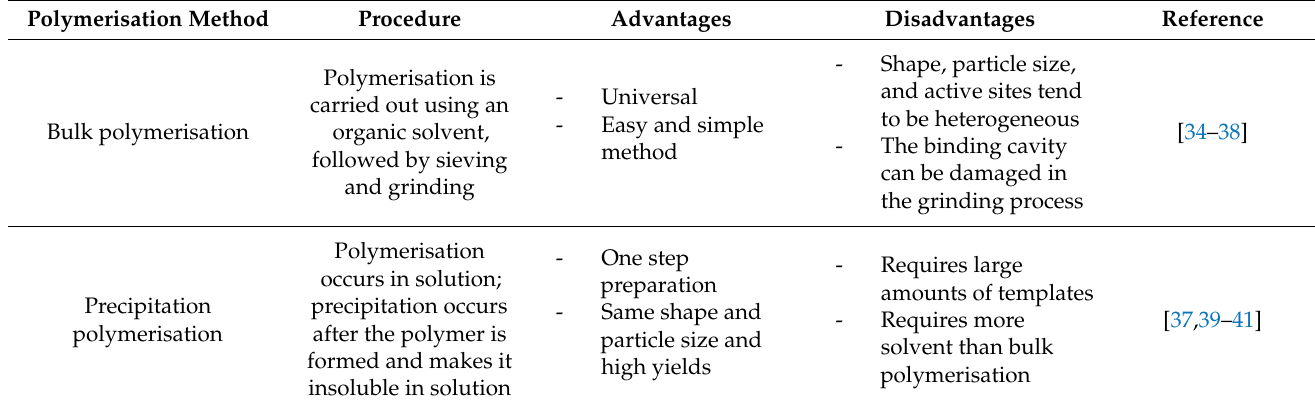
Table 2. Summary of polymerisation methods for multi-template molecularly imprinted